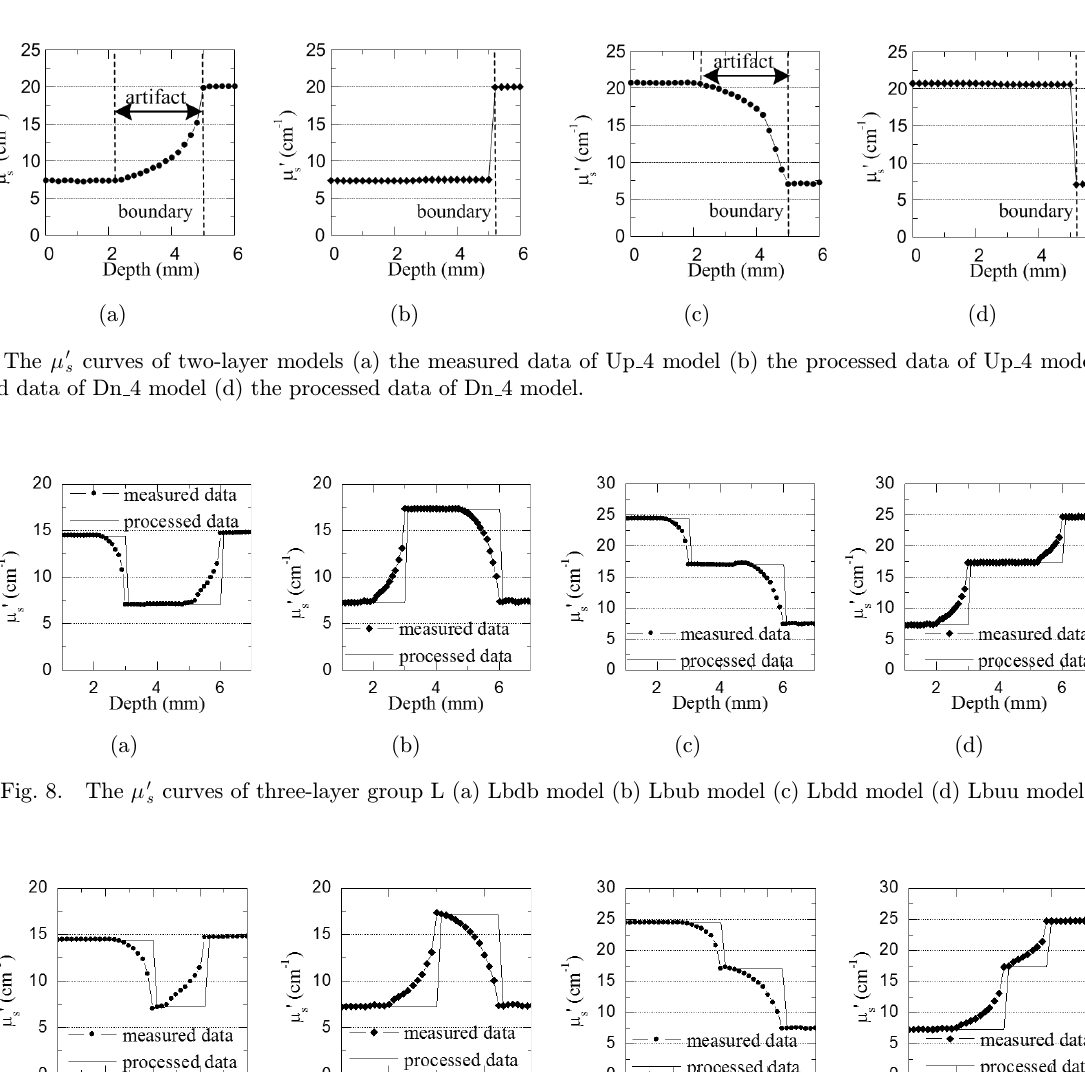
Table 4. The boundaries calculated by present algorithm